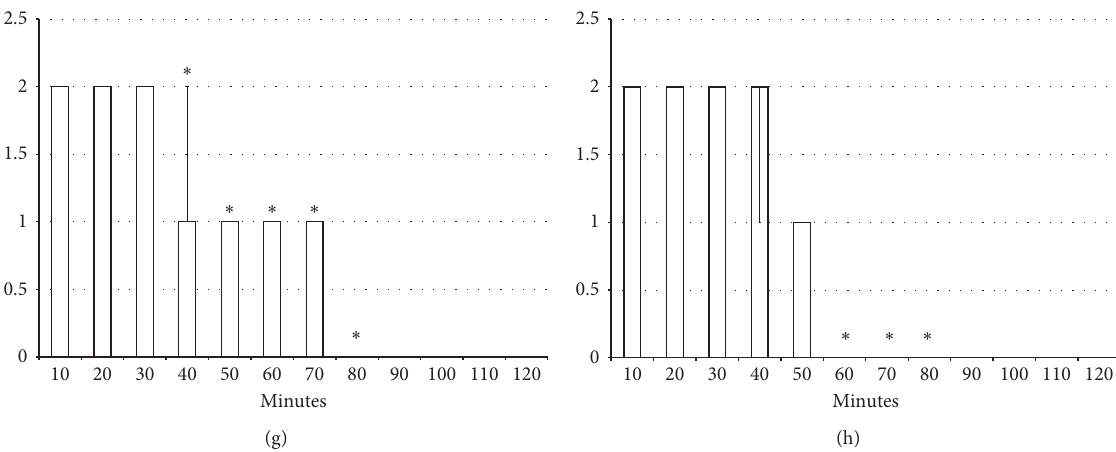
Figure 6: Axillary block (limb oedema): left brachial plexus perineural anesthesia (white bars) produced considerable fore limb oedema in the anesthetized rats. The prophylactic effect of the agents given immediately after lidocaine, saline 5ml/kg, BPC 157 10 μ g/kg, L-NAME 5mg/kg, and L-arginine 100mg/kg intraperitoneally, alone and/or together. Fore limb oedema with perineural anesthesia of the nerves of the left brachial plexus, scored 0–3. (a) Saline (control). (b) L-NAME+L-arginine. (c) BPC 157. (d) L-arginine+ BPC 157. (e) L-NAME. (f) L-NAME+BPC 157. (g) L-arginine. (h) L-NAME+L-arginine +BPC 157. Values are presented as min/med/max. ∗ P < 0 . 05 at least vs.